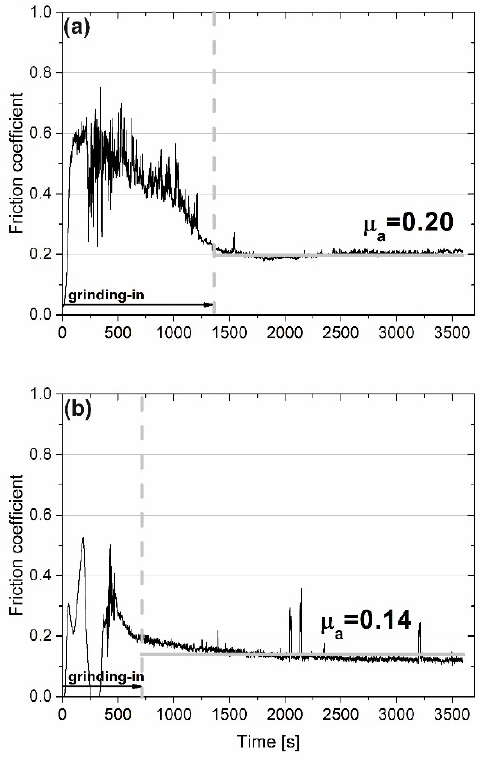
Figure 8. Results of wear test conducted at 600 °C for sintered Ni-50%NiCr(80/20) ( a ) and Ni-